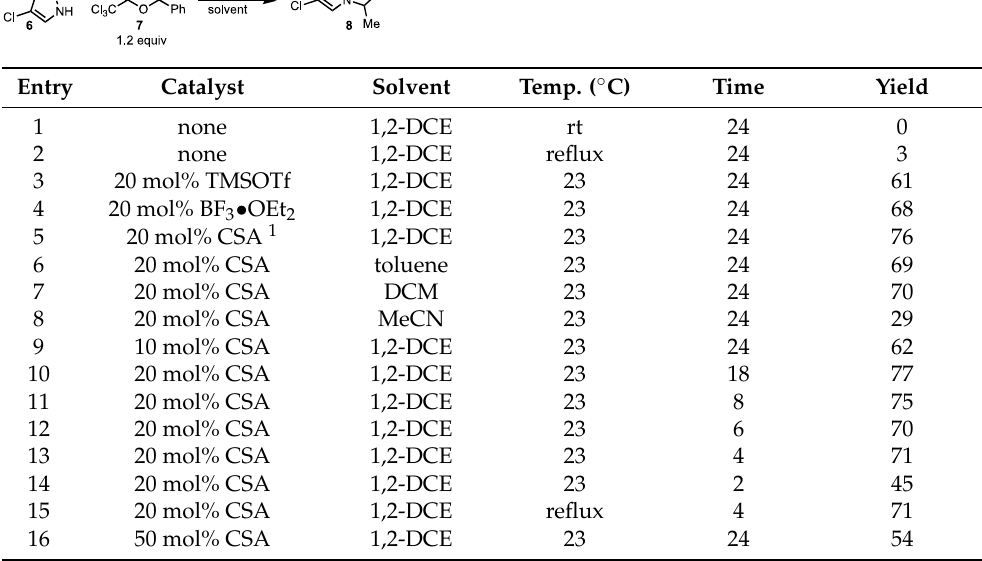
Table 1. Optimization of pyrazole N -alkylation conditions.